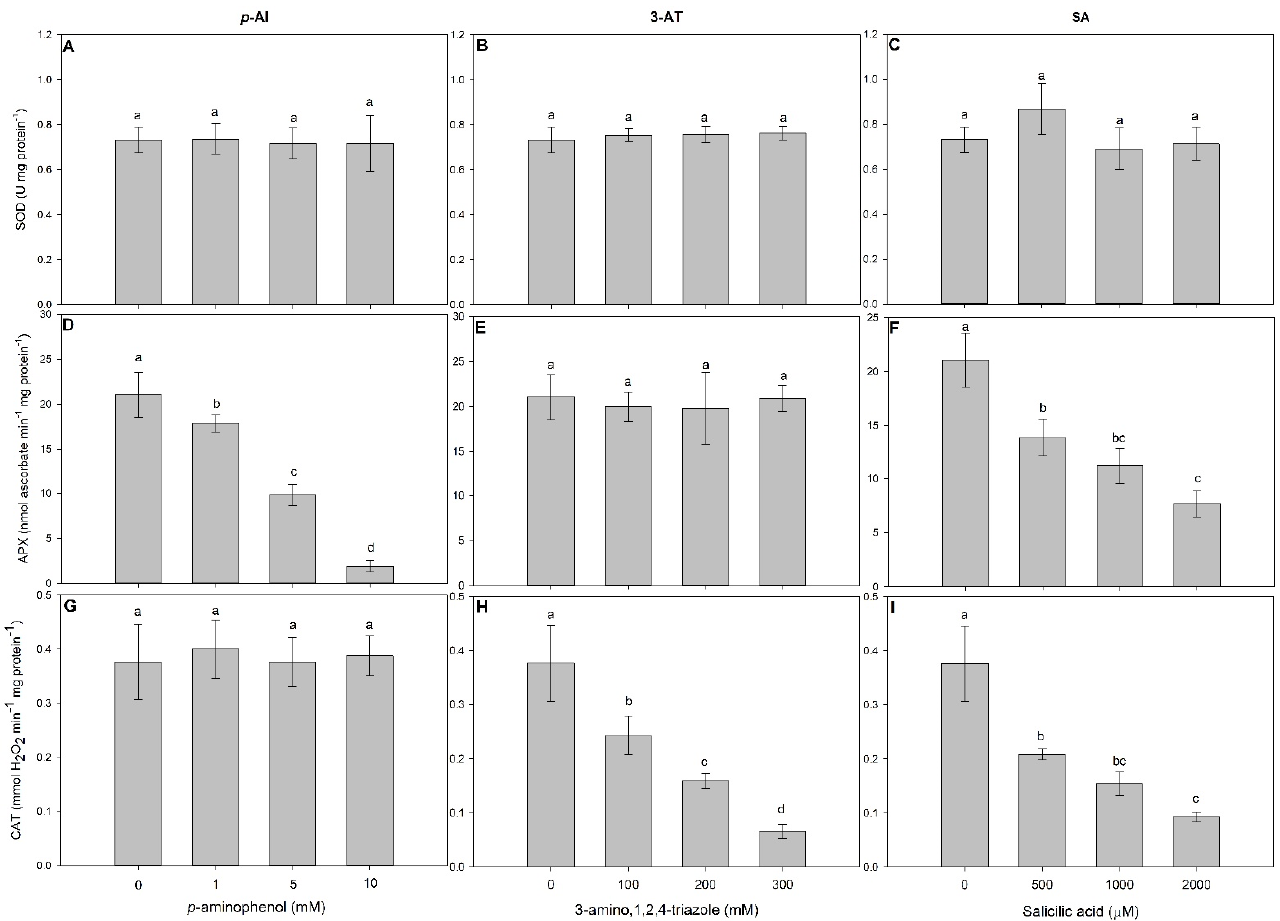
Figure 1. Effects of increasing concentrations of p -aminophenol ( p -AI), 3-amino,1,2,4-triazole (3-AT), and salicylic acid (SA) on superoxide dismutase (SOD) ( A – C ), ascorbate peroxidase (APX) ( D – F ), and catalase (CAT) ( G – I ) activities in L. minor plants after exposure for seven days. Bars represent the means ± SD of four replicates. Different letters indicate significant differences ( p > 0.05) using the post hoc Tukey test